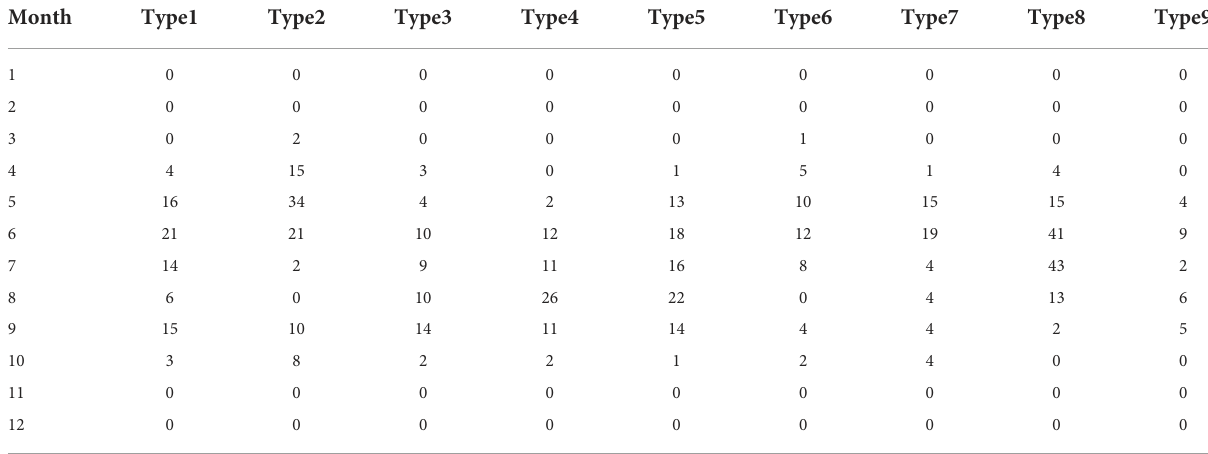
TABLE 3 O 3 exceedance events in each month for Types 1–9 during